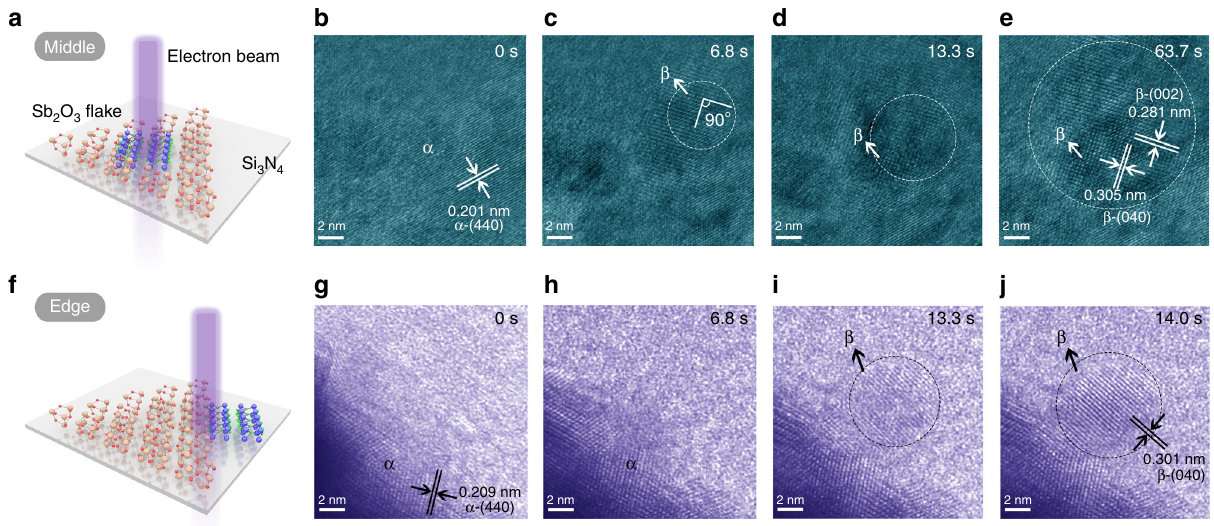
Fig. 6 In situ TEM study of Sb 2 O 3 fl akes at room temperature. a Schematic diagram of electron-beam irradiation on the middle of the Sb 2 O 3 fl ake. α - phase: brown balls for Sb atoms, red balls for O atoms. β - phase: blue balls for Sb atoms, green balls for O atoms . b − e Time-resolved HRTEM images reveal the β - phase formation at the middle of the Sb 2 O 3 fl ake; f Schematic diagram of electron-beam irradiation on the edge of the Sb 2 O 3 fl ake; g − j Time-resolved HRTEM images reveal the β -phase formation at the edge of the Sb 2 O 3 fl